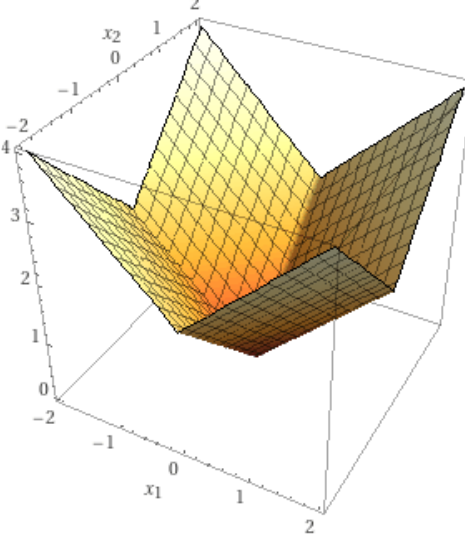
Figure 3. The graph of h = | x 1 | + | x 2 |